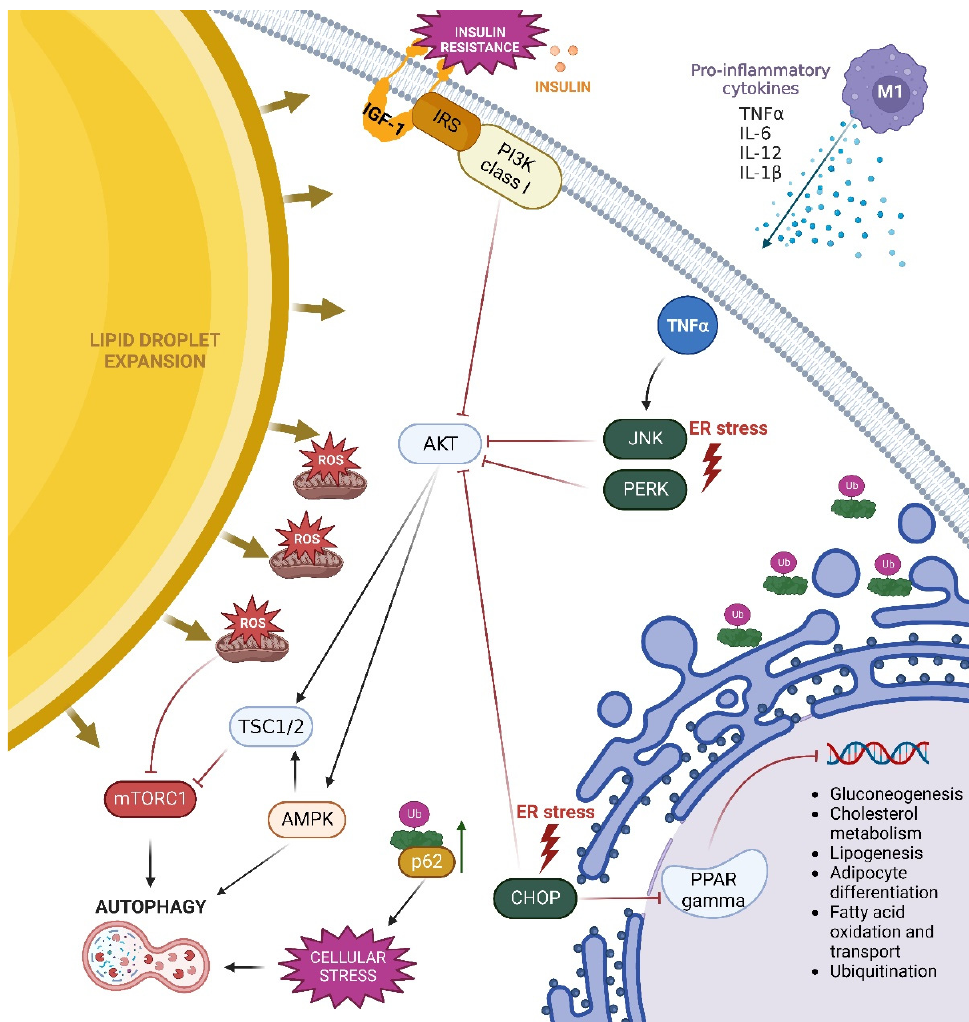
Figure 3. Pathways of autophagy activation in hypertrophic adipocytes in obesity. Enlargement of lipid droplets in hypertrophic adipocytes impairs mitochondrial oxidation and